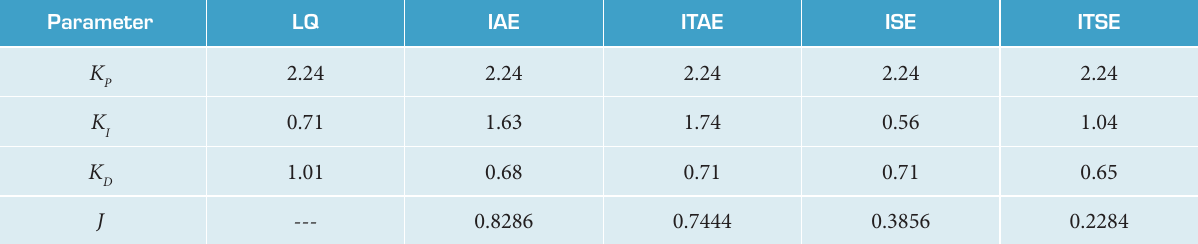
Table 1. Feedback gains and calculated cost functions.